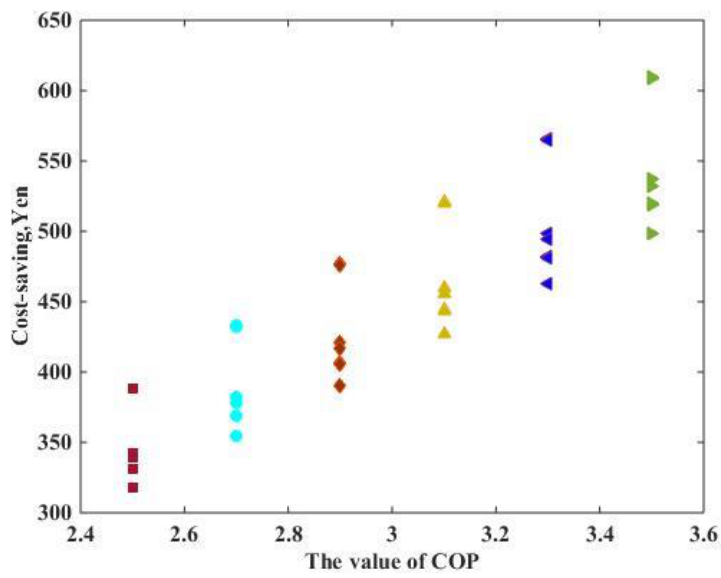
Figure 5. Cost saving by using Eco-cute under the different value of COP.